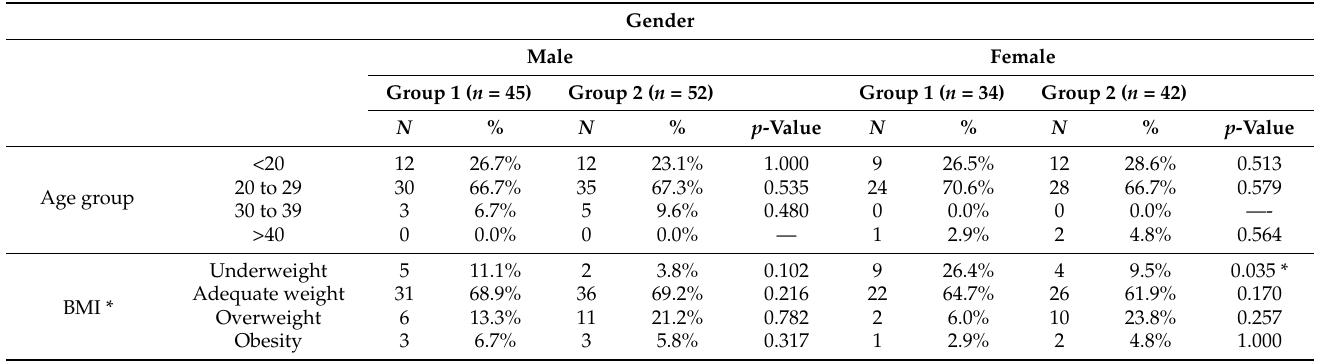
Table 1. Age group and body mass index of the participants from the University of Brasilia by gender. Gender Male